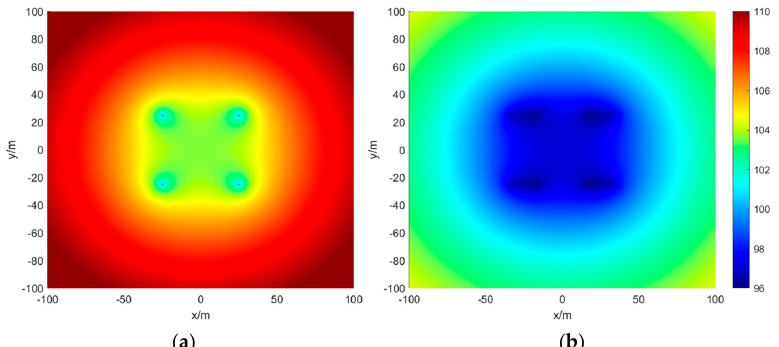
Figure 9. Distribution of pressure field in multi borehole coal seam under homogeneous state: ( a ) Unfractured coal seam, ( b ) Coal seam fracturing.